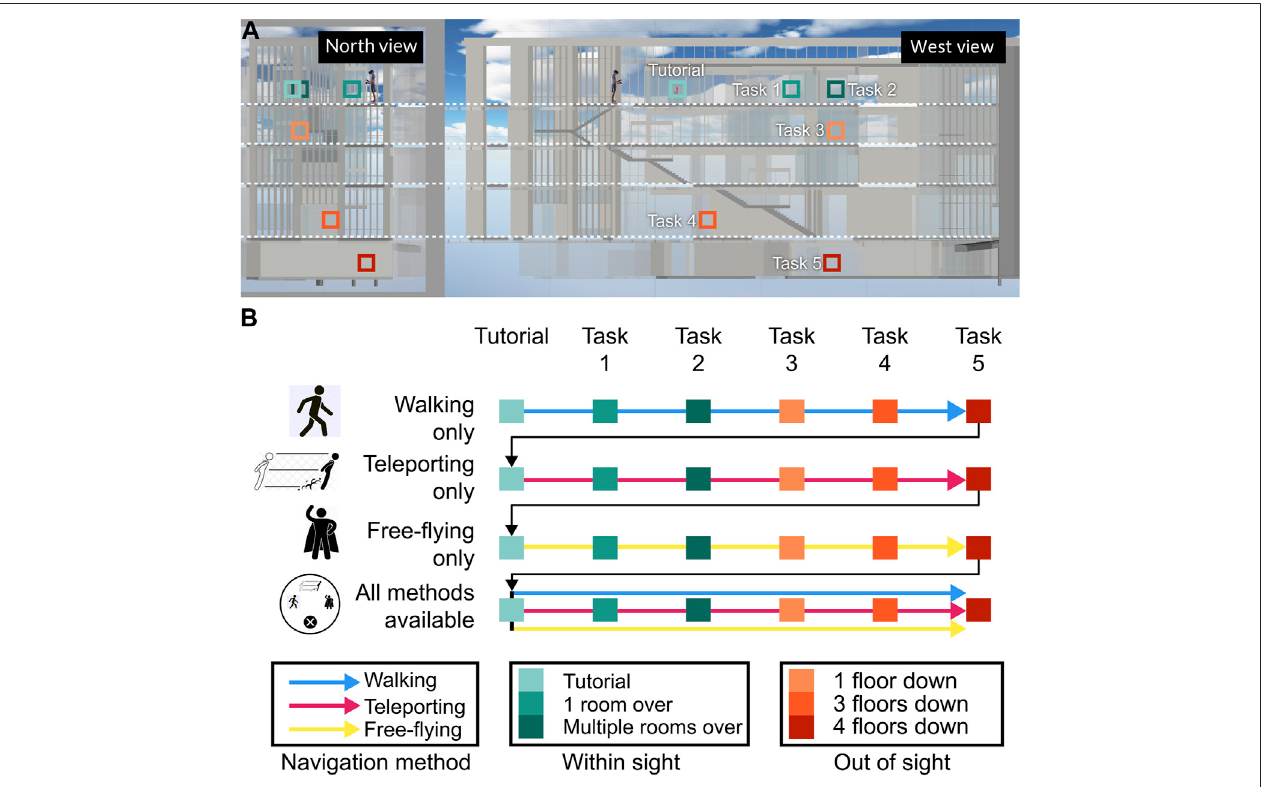
FIGURE5| ThisdistributionoftasksacrossLuddyHallandtasksequence. (A) :The fi venavigationtasks(plustutorial)attheirlocationsintwoalignedcross-section views of the building. (B) : All 24 tasks in sequence with color-coded dif fi culty level and possible navigation methods.